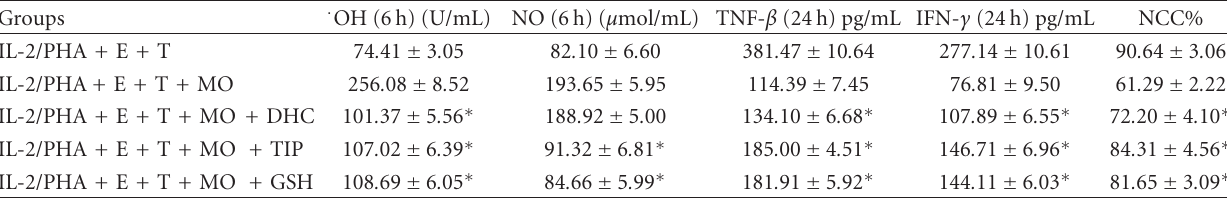
Table 4: The e ff ect of RNM scavengers on NK-cell-mediated killing of K562 cells.